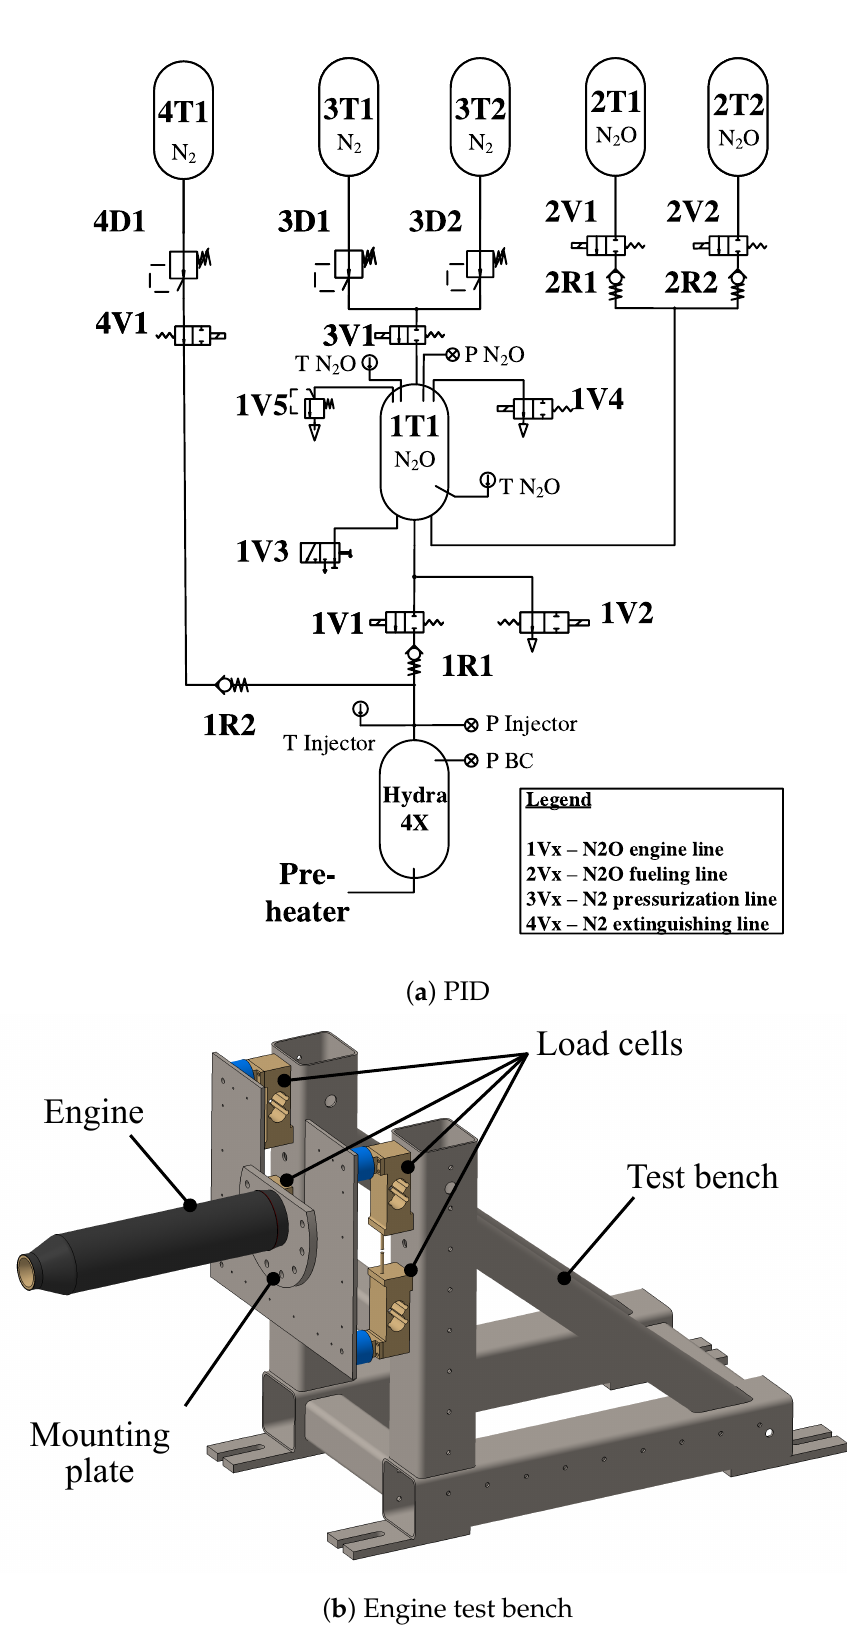
Figure 5. ( a ) Fluid plan of the fluid supply system; ( b ) Engine test bench with the engine HYDRA